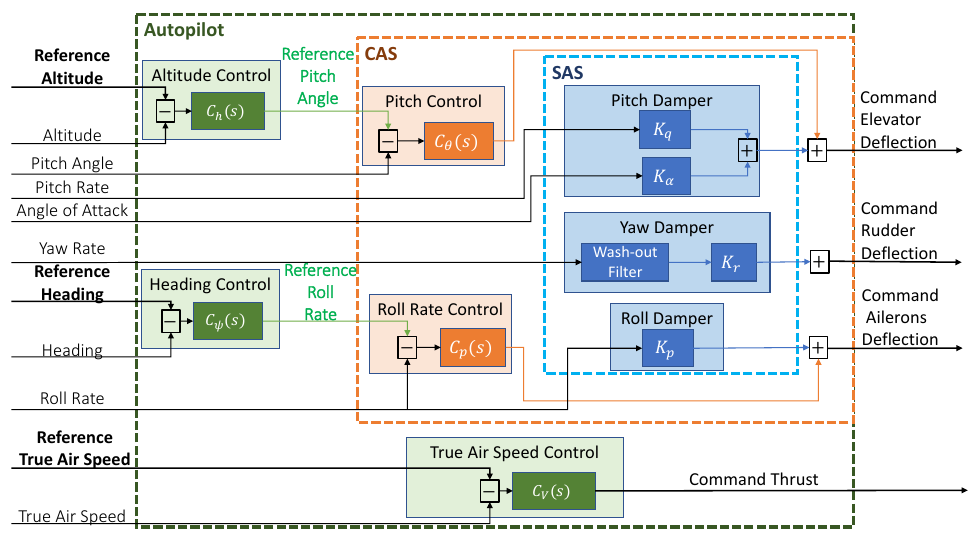
Figure 3. Schematic of the Flight Control